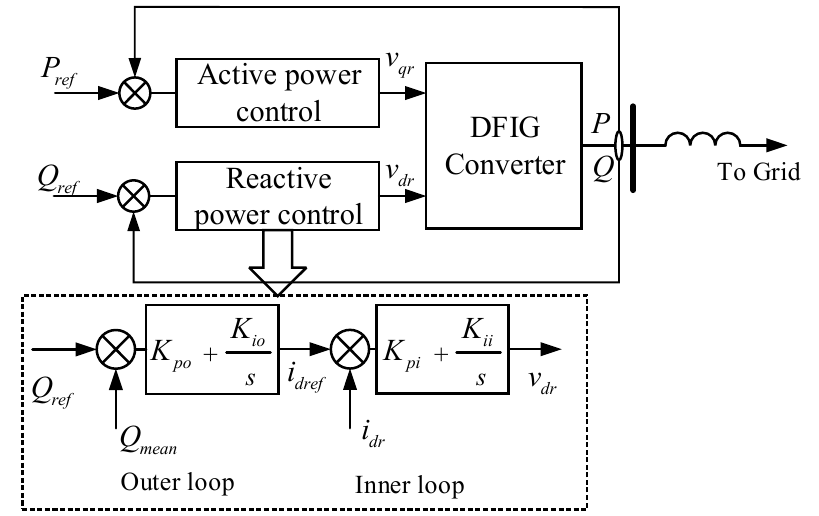
Figure 2. DFIG reactive damping control strategy diagram.